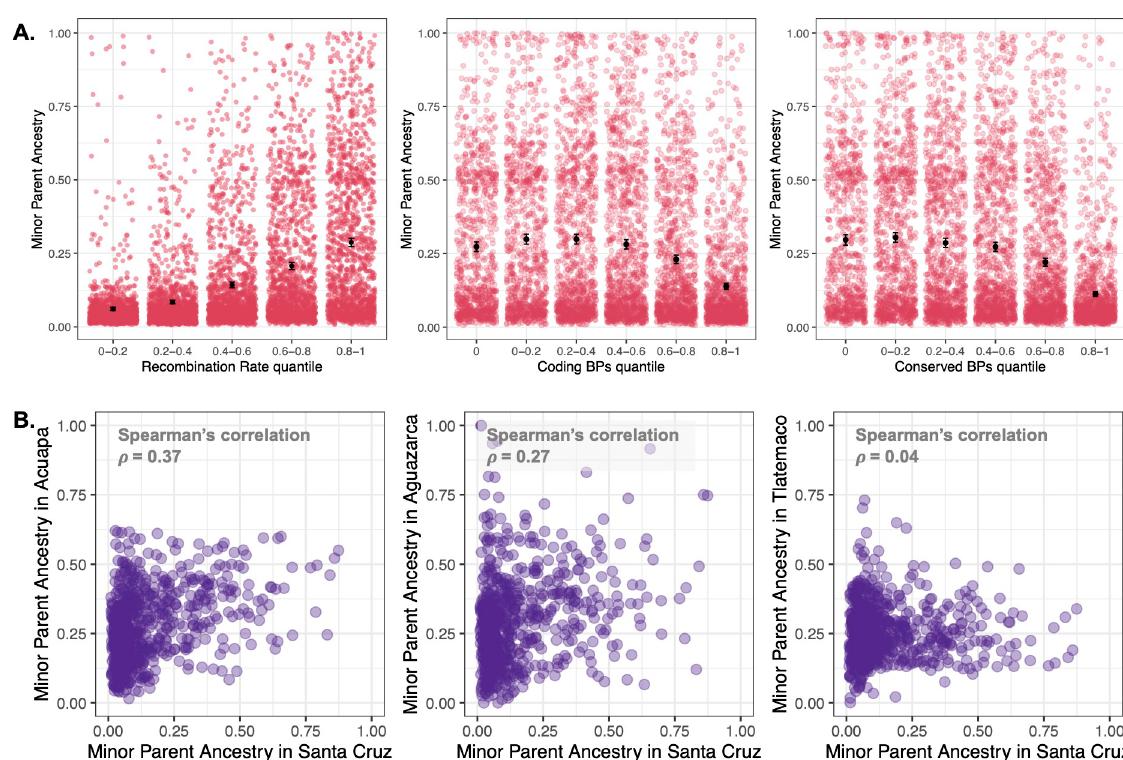
Fig 2. Relationship between minor parent ancestry, recombination rate and functional basepairs in X . birchmanni × X . cortezi hybrid populations, as well as cross-population type comparisons. A. Minor parent ancestry ( X . birchmanni ancestry) in the Santa Cruz hybrid population is higher in regions of the genome with higher recombination rates. Semi-transparent points show results from individual 100 kb non-overlapping windows, black points and whiskers show the mean ± two standard errors of the mean. After accounting for recombination rate by averaging ancestry in 0.25 cM non-overlapping windows, we also observe a strong negative correlation between minor parent ancestry and the number of linked coding (middle) and conserved basepairs ( right ) . We find the same results when analyzing data from the Huextetitla hybrid population and across a range of window sizes (S1 and S4 Tables). Note that results for A are shown in quintiles for visualization but statistical tests reported in the text were performed on unbinned data. B . Correlations in local ancestry, plotted here in 1 Mb non-overlapping windows. Cross-population ancestry correlations between Santa Cruz (or Huextetila–S10 Table) and X . birchmanni × X . malinche hybrid populations are significant in all comparisons except for the majority X . malinche population Tlatemaco (far right; see main text & Text F in S1 File). Some of the ancestry covariance between X . birchmanni × X . cortezi and X . birchmanni × X . malinche hybrid populations can be explained by shared features of genome architecture such as the locations of coding and conserved basepairs and the local recombination rate, but substantial covariance remains after accounting for these features (S12